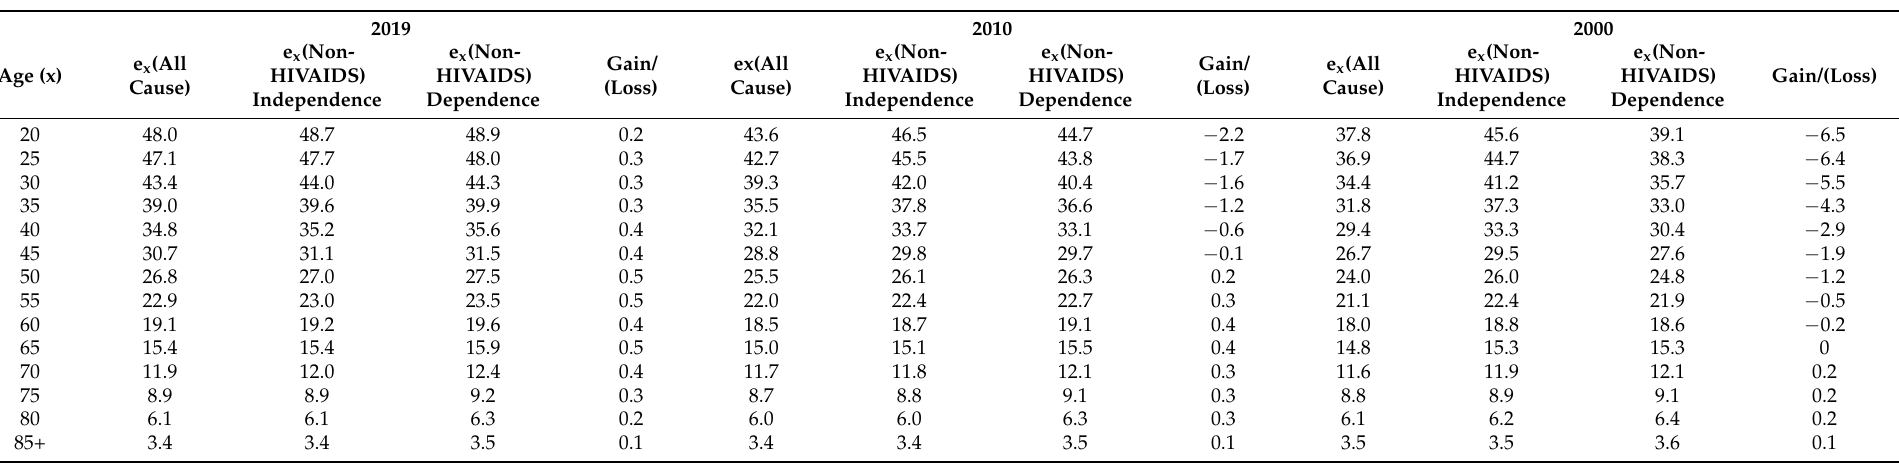
Table 7. Life expectancy gain/loss analysis for